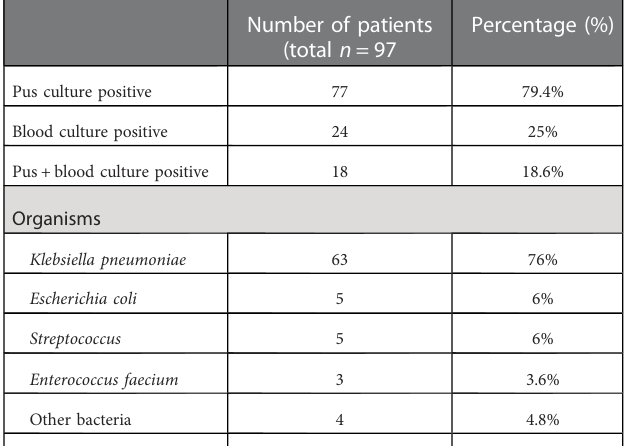
TABLE 3 Microbiological fi ndings.